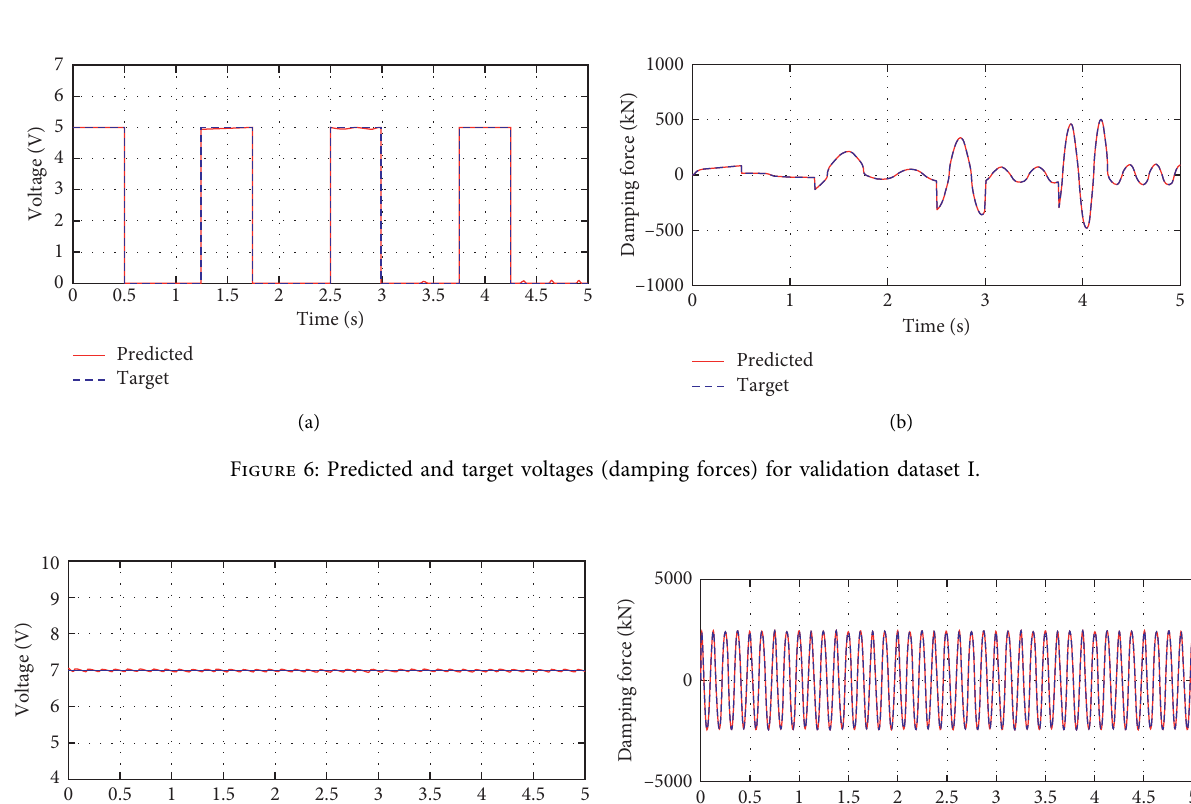
Figure 5: Predicted and target voltages (damping forces) for the training dataset.